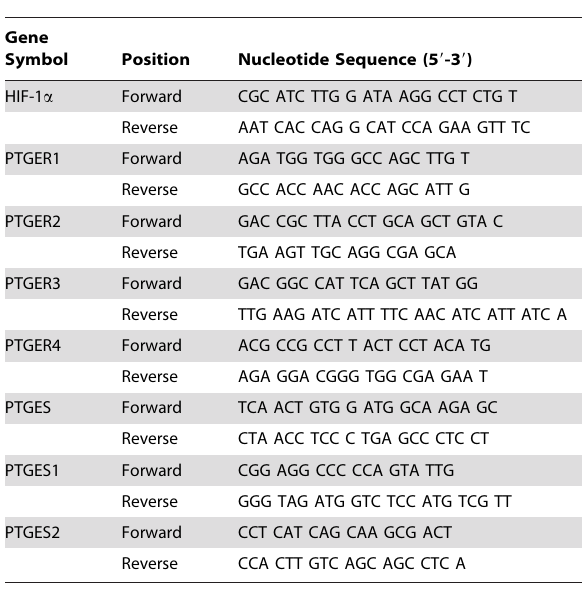
Table 3. Sequences of Taqman primers and probe.